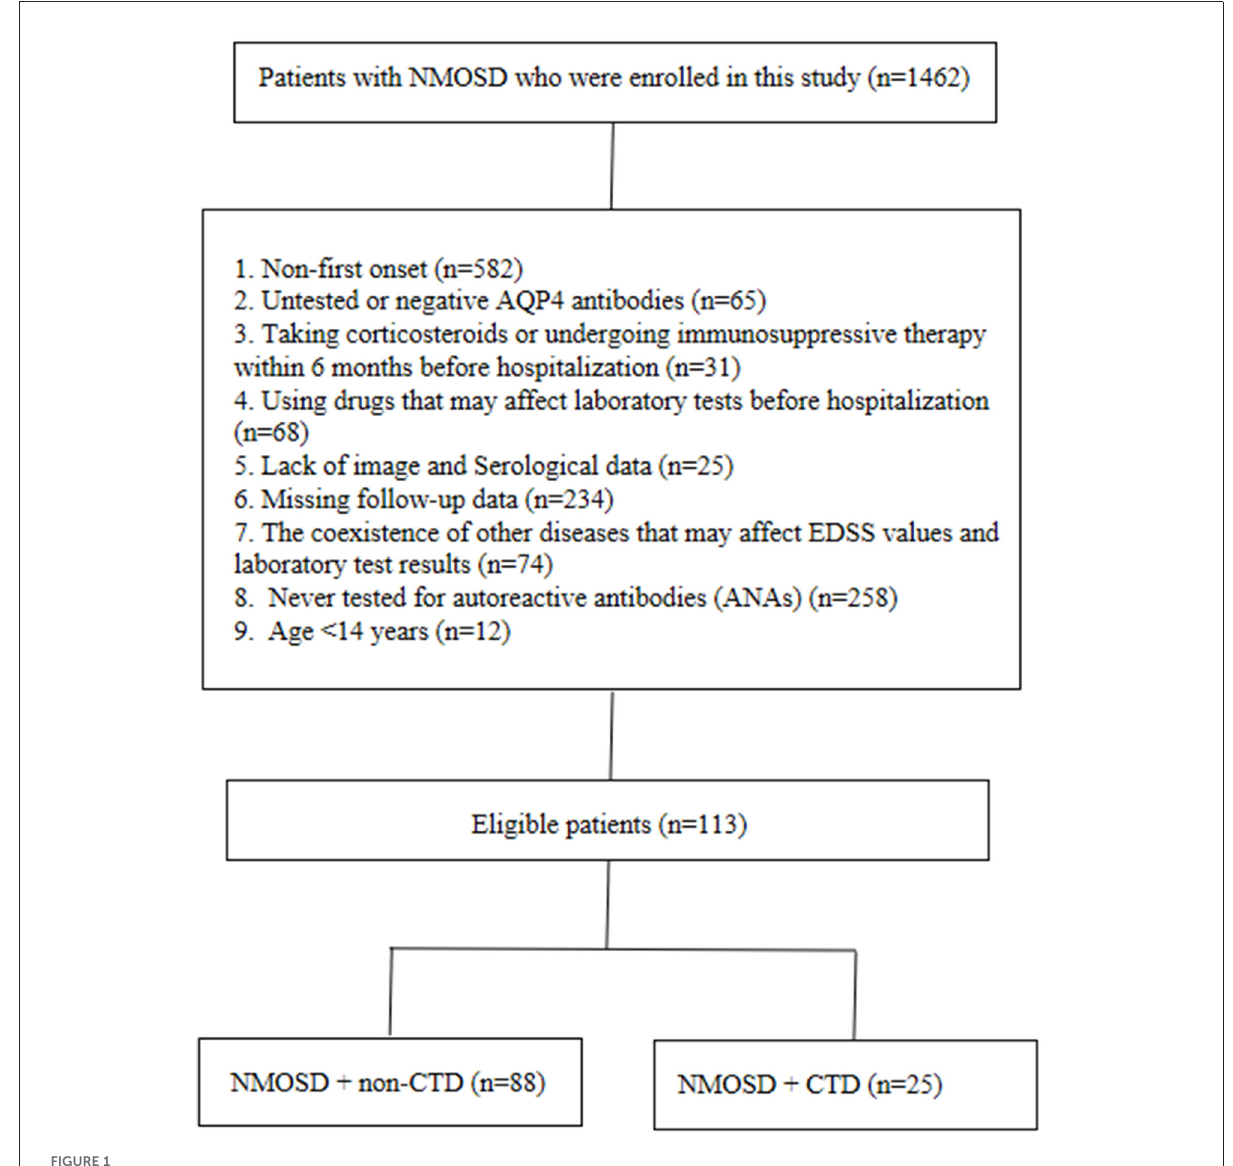
FIGURE1 Patient